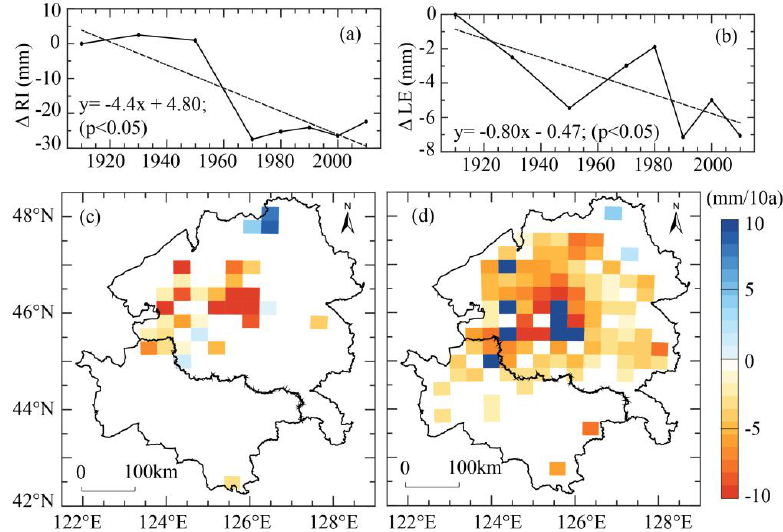
Figure 8. Trends of the plain-wide and grid-level deviations (against the 1910s) of the WRF-simulated RI ( a , c ) and land evaporation ( b , d ) in growing season. In ( a , b ), the dashed lines are the linear correlation lines. In ( c , d ), only grids with significant trends are colored.